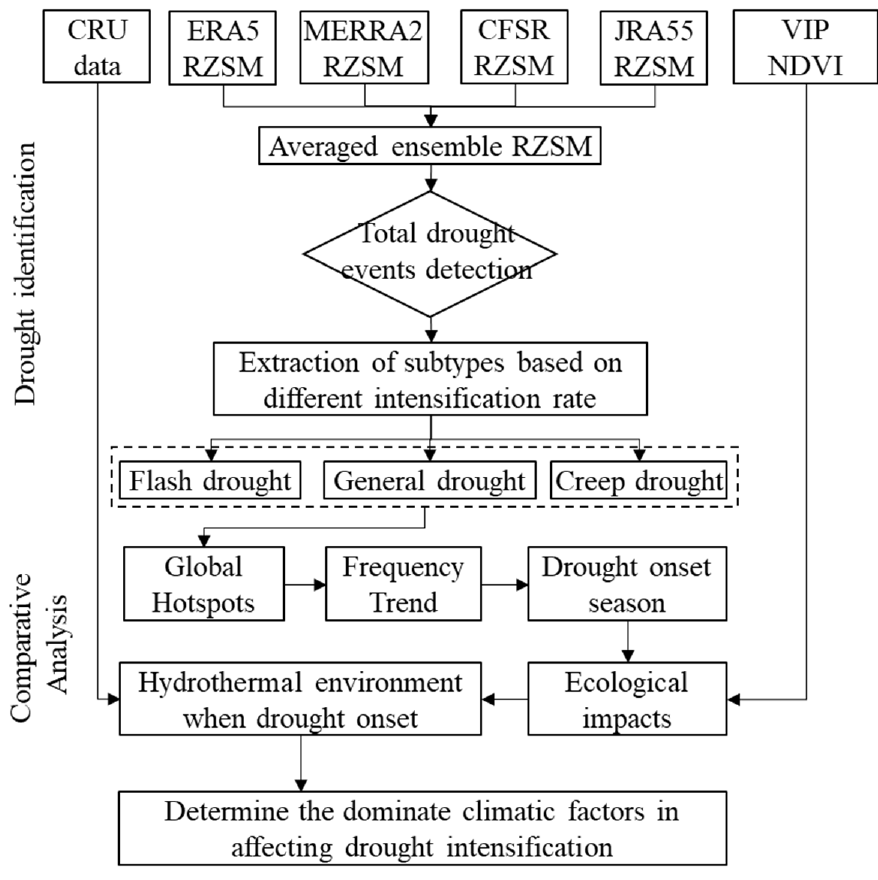
Figure 3. The flowchart of this study.